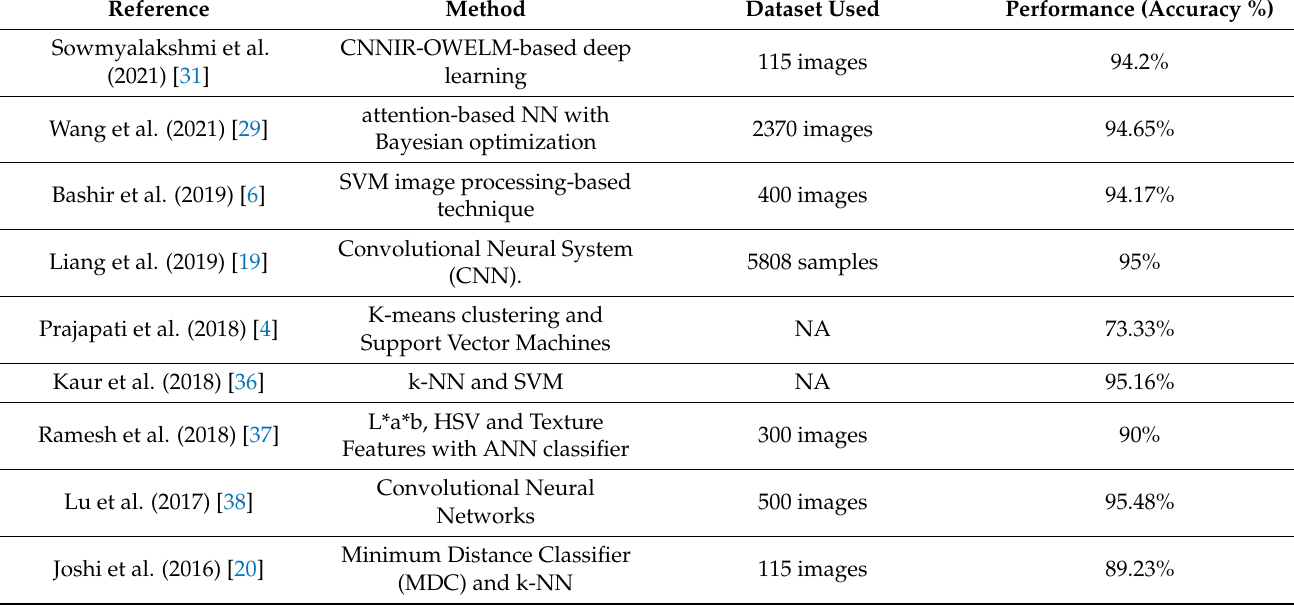
Table 1. Summary of different latest studies on rice disease classification with their